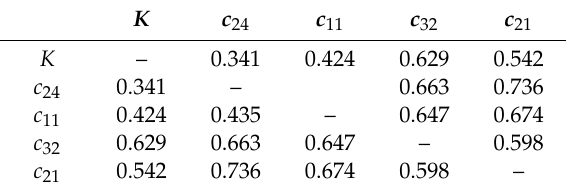
Table 5. Sub-unit motive weight values h ( · ) of starting points and tourist